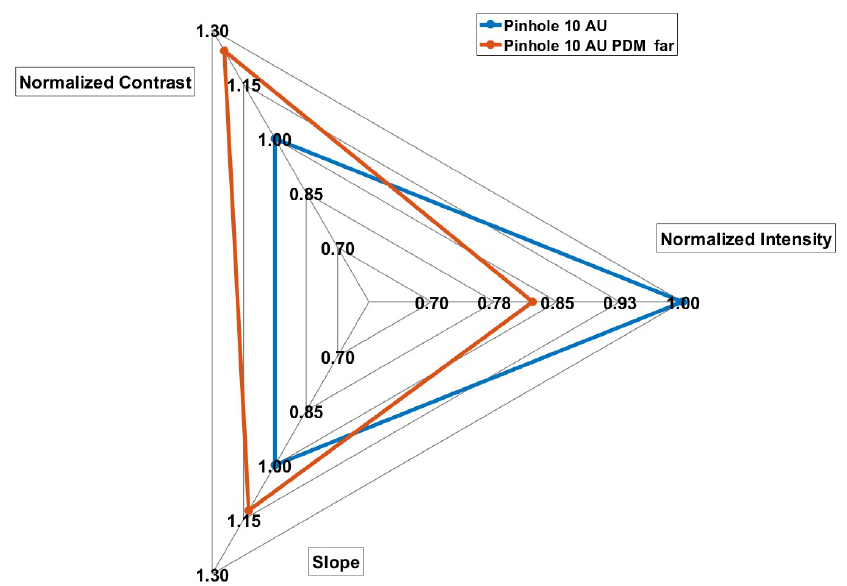
Figure 14. Comparison of the image characteristics of the ASIC with the 10 AU pinhole in-focus and with PDM far